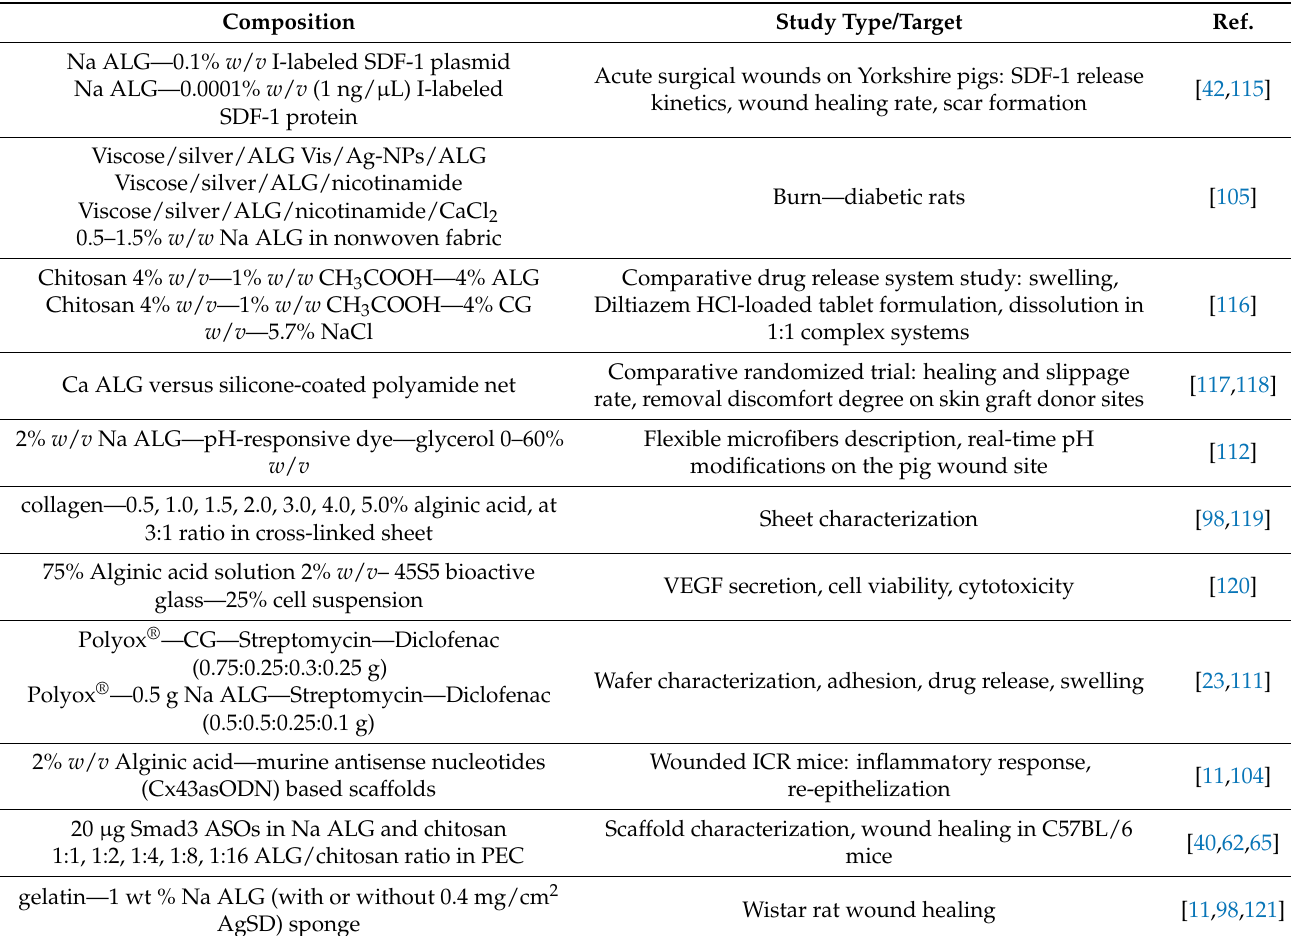
Table 4. Other alginate-based dressings used for wound healing. Study Type/Target Ref.